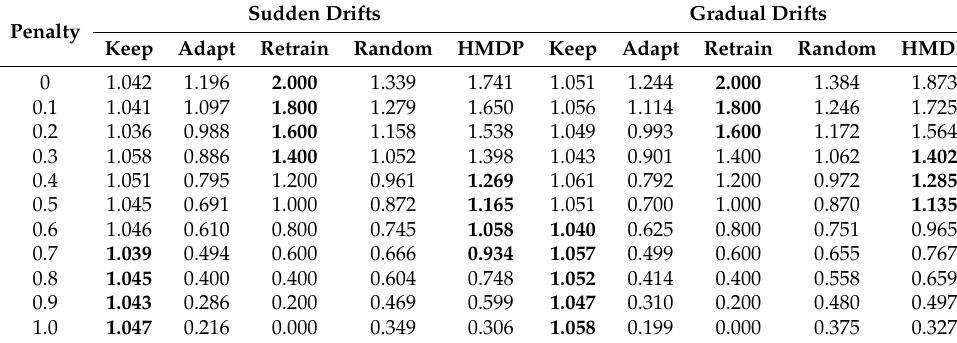
Table 3. The average reward of the 16 sudden and gradual duration